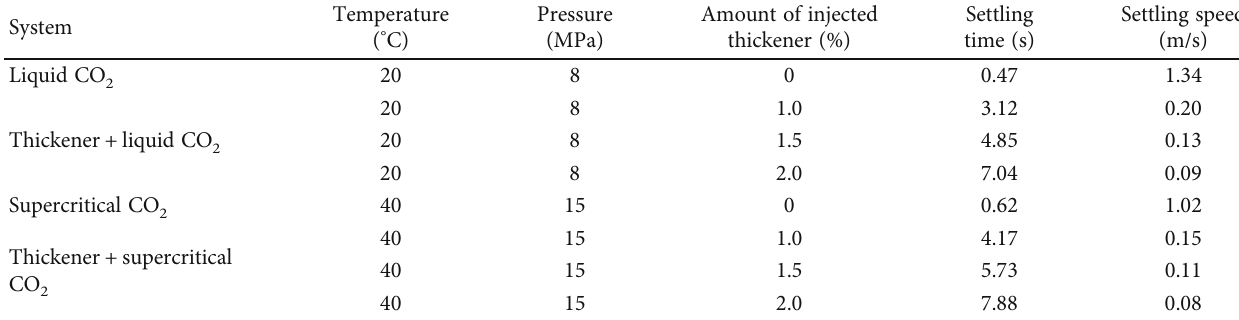
fracturing fl uids. 2